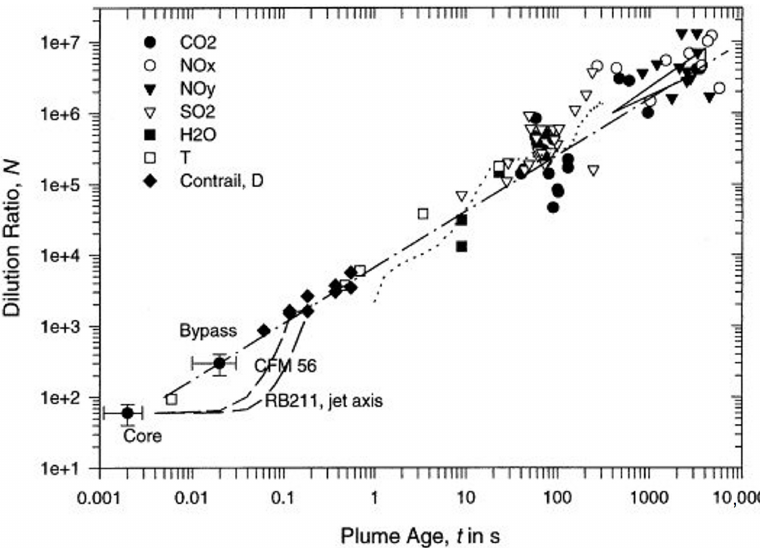
Figure 3. Dilution ratio against plume age derived from empirical data. Marker shapes correspond to tracer species as displayed in legend. See original for further marker descriptions. The dash-dotted line shows the interpolation that is represented by Equation (1). Reprinted with permission from Schumann et al. [46]. Copyright 2022,